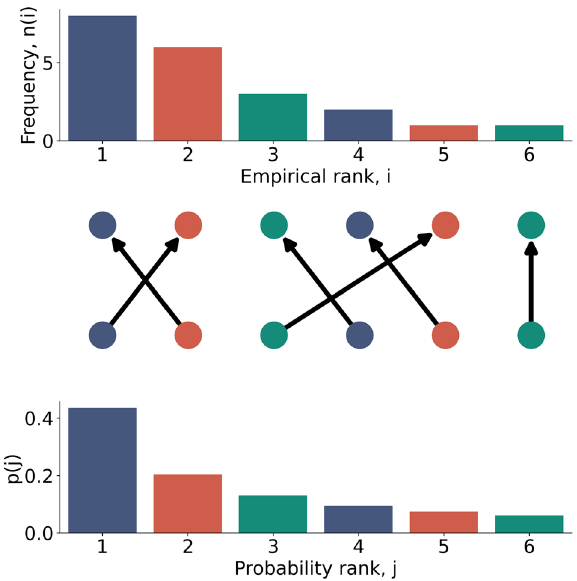
Figure 3. An example mapping from probability to empirical ranks. The observed data n = [ 8, 6, 3, 2, 1, 1 ] can arise from any valid permutation of events from the probability distribution. Here the permutation is s = [ 2, 1, 5, 3, 4, 6 ] . The 1st most likely event is observed the second most times ( s [ 1 ] = 2 ), etc. The likelihood of the data given this permutation is p ( n | s , θ ) = p 6 1 p 8 2 p 1 3 p 3 4 p 2 5 p 1 6